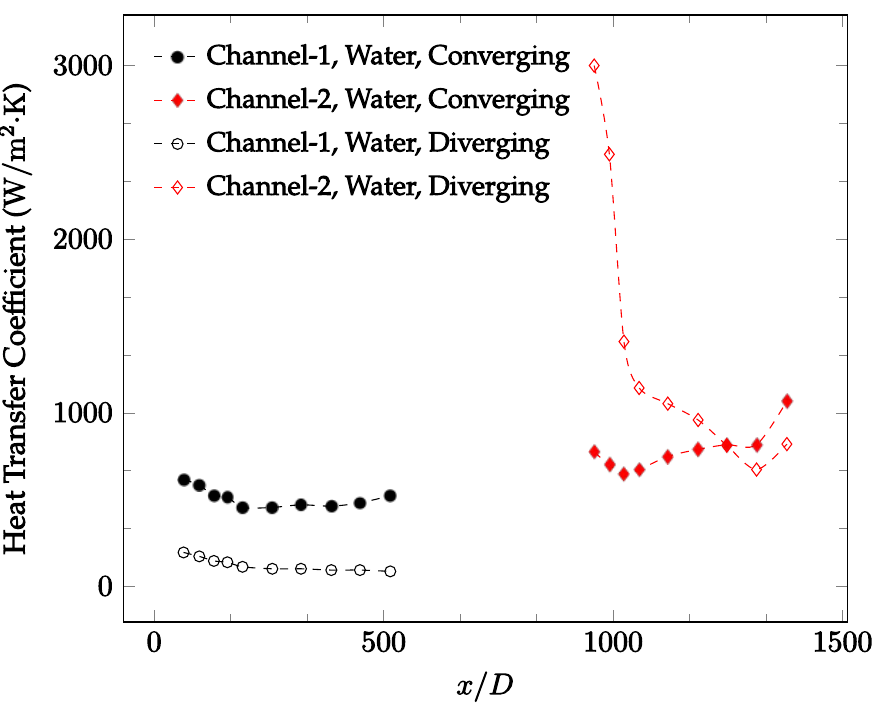
Figure 11. Change in convective heat transfer coefficient of deionized water as a function of dimen- sionless distance for a Reynolds number of 50. Converging and diverging nozzles are used as con- nectors.